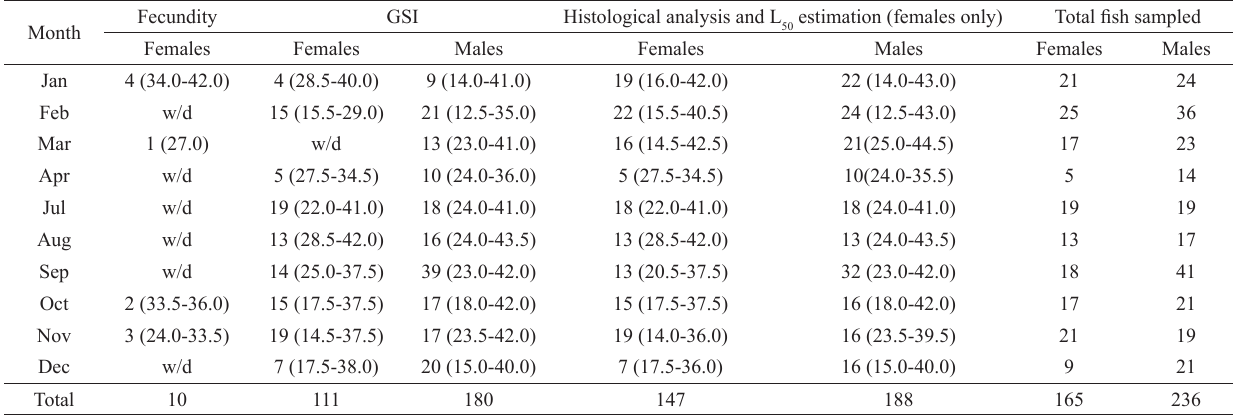
Table 1. Number of Pinguipes brasilianus used for each analysis, categorized by sex and month. The size range (TL, in cm) is showed in parenthesis. Note that most fish sampled in summer (January to March) came from the monitoring of the recreational fishery, and hence it was only possible to keep the gonads but not the whole fish to estimate GSI. W/d: without